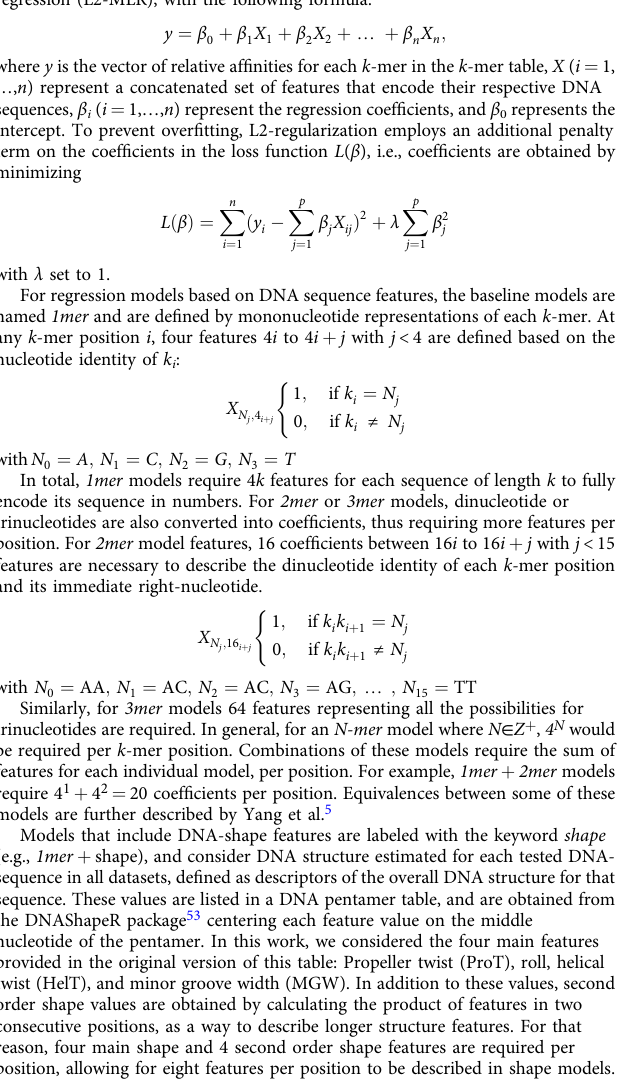
table into 10 fi xed groups of equal size, iteratively fi tting L2-MLR models with nine out of ten groups, and then assessing coef fi cient of determination ( R ²) in the held- out group. This is done using scikit-learn 54 . As a summary statistic for each tiled k - mer table, we report the median R ² of all held-out groups (Supplementary Data 1 and 4). As a quality control and to remove datasets with low variability and enrichment for mapped k -mers, at this stage we fi lter out datasets whose minimum testing R ² value across all models for all tiled k -mer tables is lower than zero (i.e., model is worse than using the mean of all values as a single